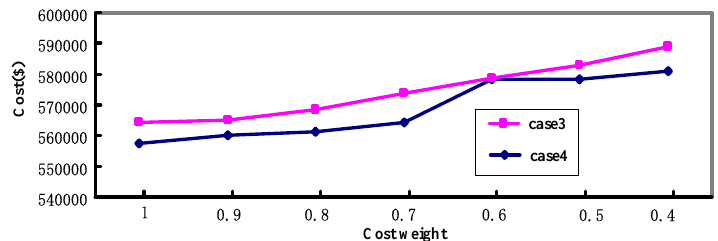
Figure 6. The influence of PHEVs on operation cost in smart grid.